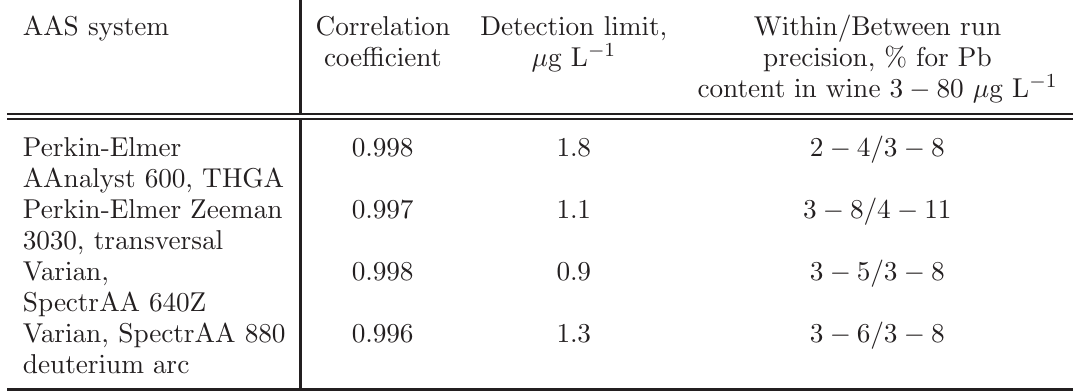
Table 3 Analytical figures of merit for direct ETAAS determination of Pb by using different atomic absorption